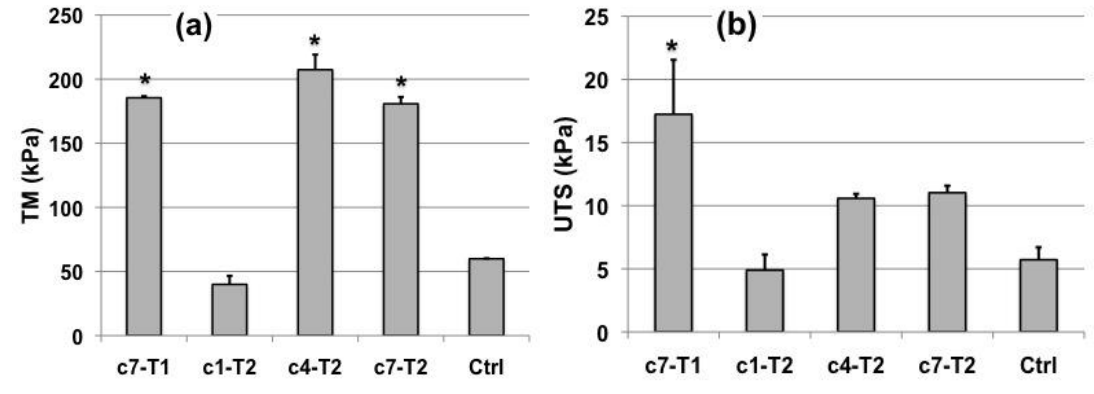
Figure 5. ( a ) Tensile modulus (TM) of the most representative gels: * denotes treatments with statistically significant differences as compared to the control (p < 0.01). ( b ) Ultimate tensile stress (UTS) of the most representative gels: * denotes treatments with statistically significant differences as compared to the control (p <